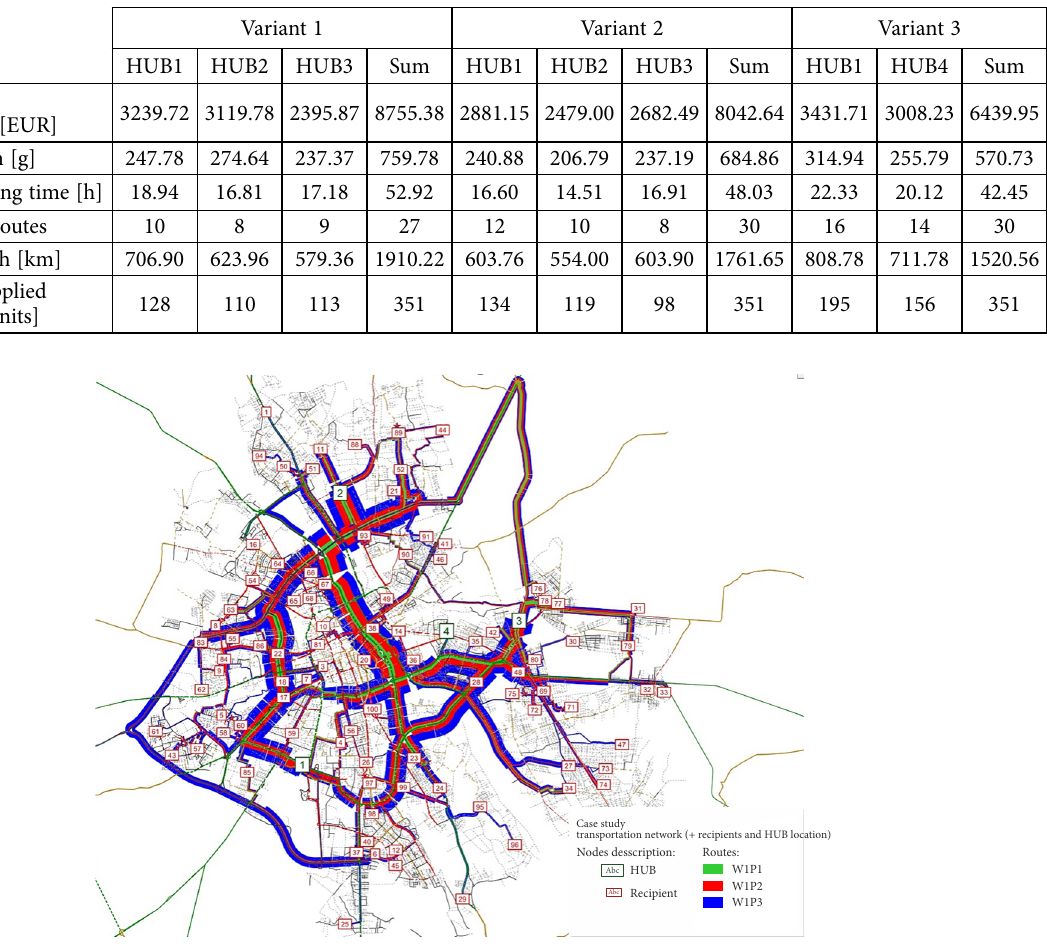
Fig. 1. Transport network, localization of depots and recipients Table. Calculation results sheet for organizational variants